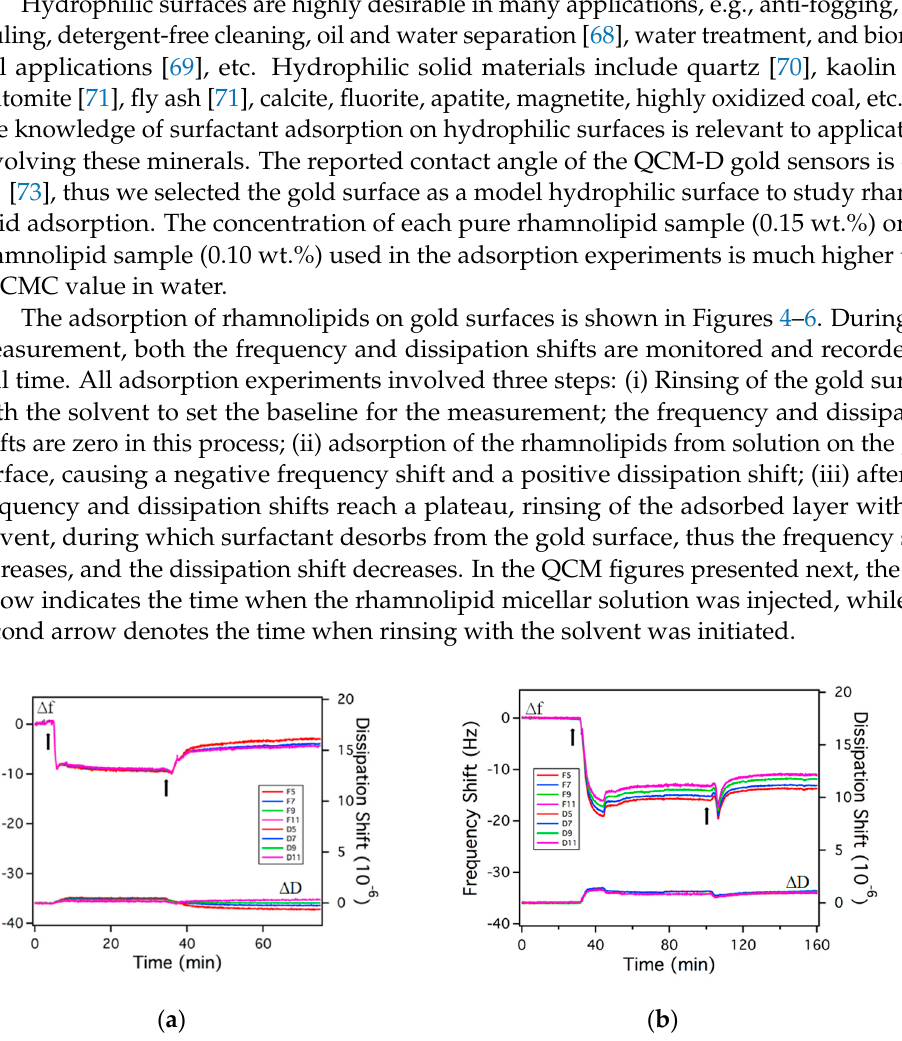
Figure 4. Δ f and Δ D over time of a gold sensor surface responding to exposure to ( a ) 0.15 wt.% R95M90 aqueous solution and ( b ) 0.15 wt.% R95M90 in 3.5 wt.% NaCl aqueous solution. The first arrow indicates the time when the rhamnolipid solution was injected and the second arrow indicates the time when solvent rinsing was initiated. Fi and Di shown in the insert are the frequency and dissipation at i th overtone, respectively.